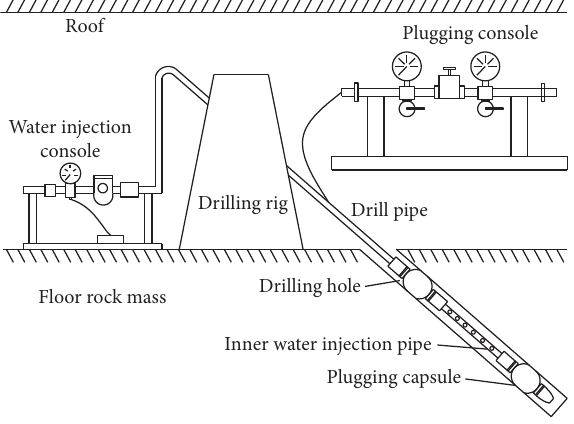
Figure 9: The double-end plugging leakage detection device.